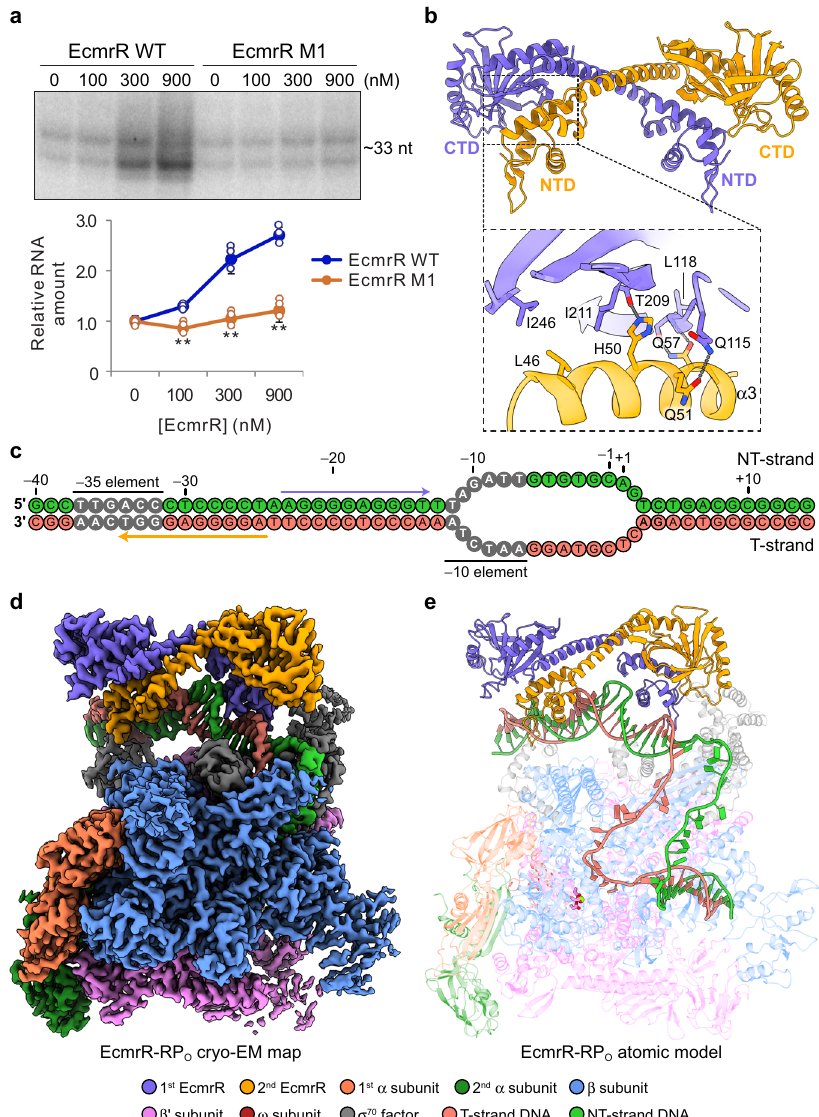
Fig. 1 Structural and functional overview of EcmrR. a Activation of in vitro transcription from a synthetic template DNA with a 19-bp promoter spacer by wild-type EcmrR (EcmrR WT) or EcmrR bearing mutations in the cross-subunit NTD-CTD interface (L46A/H50A/Q57A, designated EcmrR M1). The concentrations (in nM) of EcmrR WT and EcmrR M1 are indicated. The experiment was repeated three times and similar results were obtained. RNA products were quanti fi ed from these three independent experiments and are shown as mean ± SD. Both of the two distinct RNA bands were quanti fi ed, and their signals are combined for plotting. Statistical analyses were performed using the unpaired Student ’ s t -test (two-tailed). ** P < 0.01. b Structure of EcmrR dimer. The model was extracted from the cryo-EM structure of EcmrR-RP o . Cross-subunit NTD-CTD interactions are shown in the dashed box. Interacting residues are shown as sticks. Hydrogen bonds are shown as gray dotted lines. c Schematics of synthetic promoter DNA scaffolds in EcmrR-RP o . The two halves of the palindromic sequence recognized by EcmrR dimer are highlighted by medium blue and orange arrows, respectively. NT-strand, non-template strand; T-strand, template strand. d Cryo-EM map of EcmrR-RP o . The map was generated by merging the consensus map of the full EcmrR-RP o complex and the focused map of EcmrR-spacer DNA subcomplex from EcmrR-RP o (Supplementary Fig. 2) using the Combine Focused Maps tool in Phenix 46 . e Overall cryo-EM structure of EcmrR-RP o . Three catalytic aspartate residues ( β ' D460, β ' D462 and β ' D464) and the Mg 2 + ion in the polymerase active center are shown as violet sticks and green sphere, respectively. Source data are provided as a Source Data fi